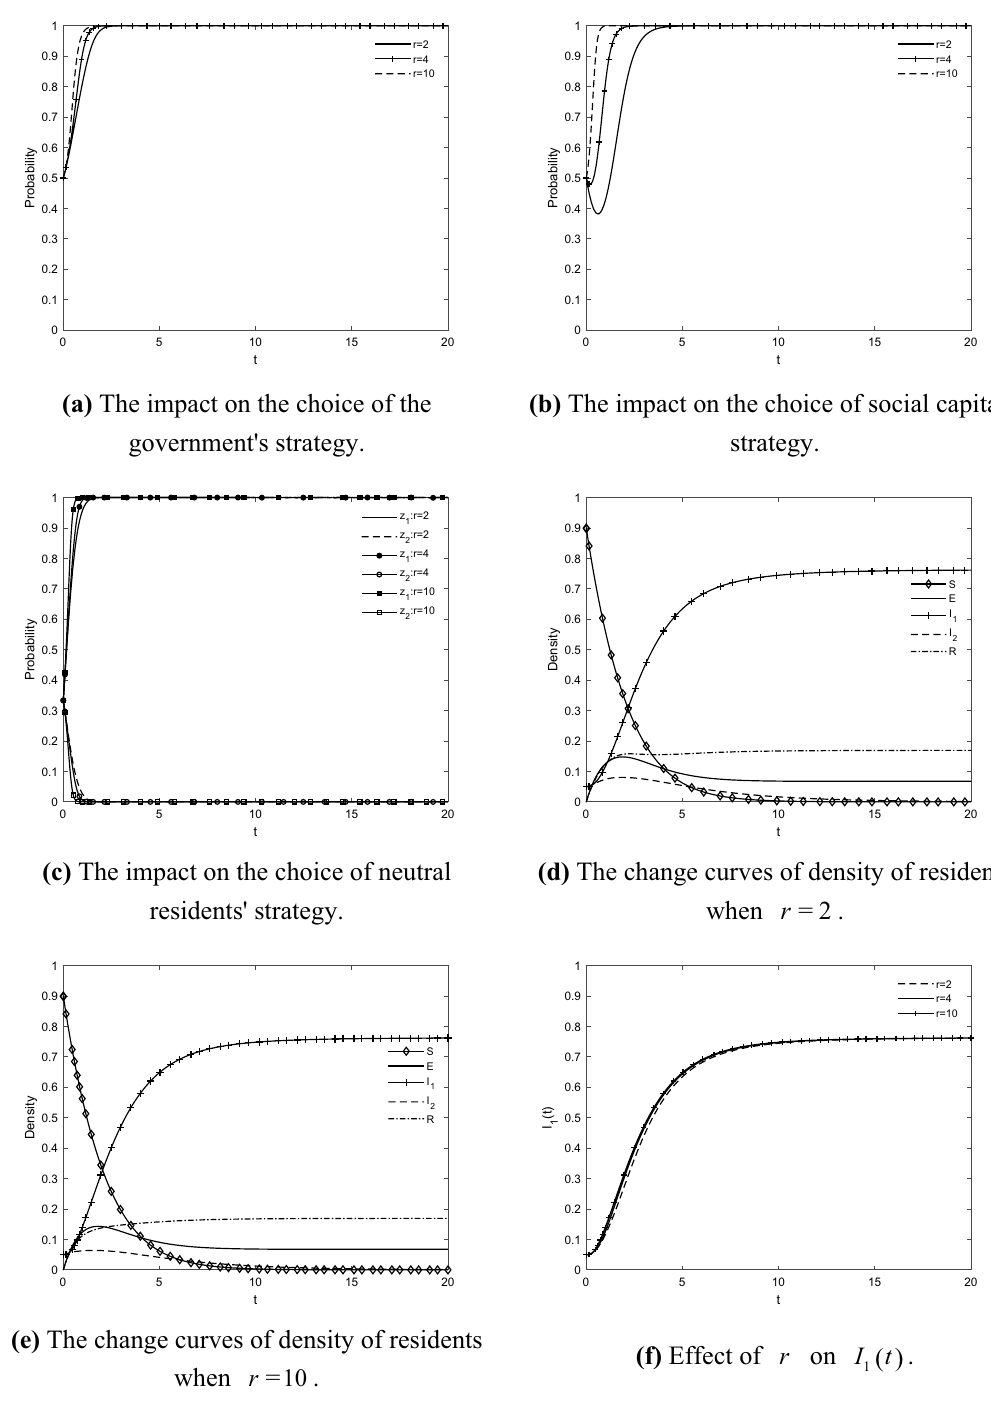
Figure 7. The impact of r on the choice of tripartite strategy and residents’